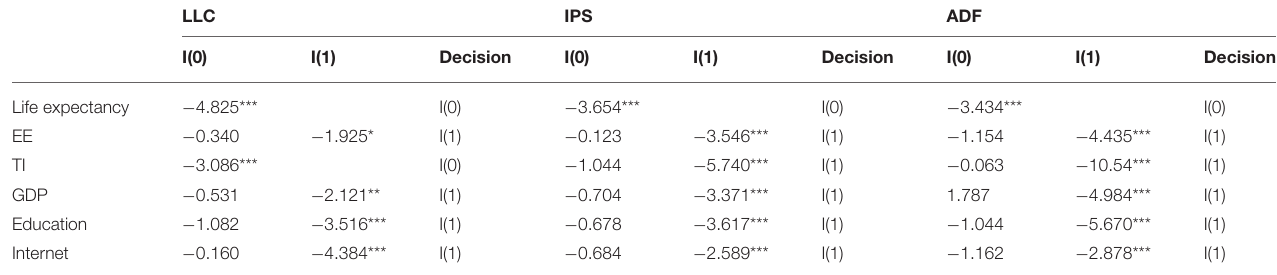
TABLE 2 | Unit root